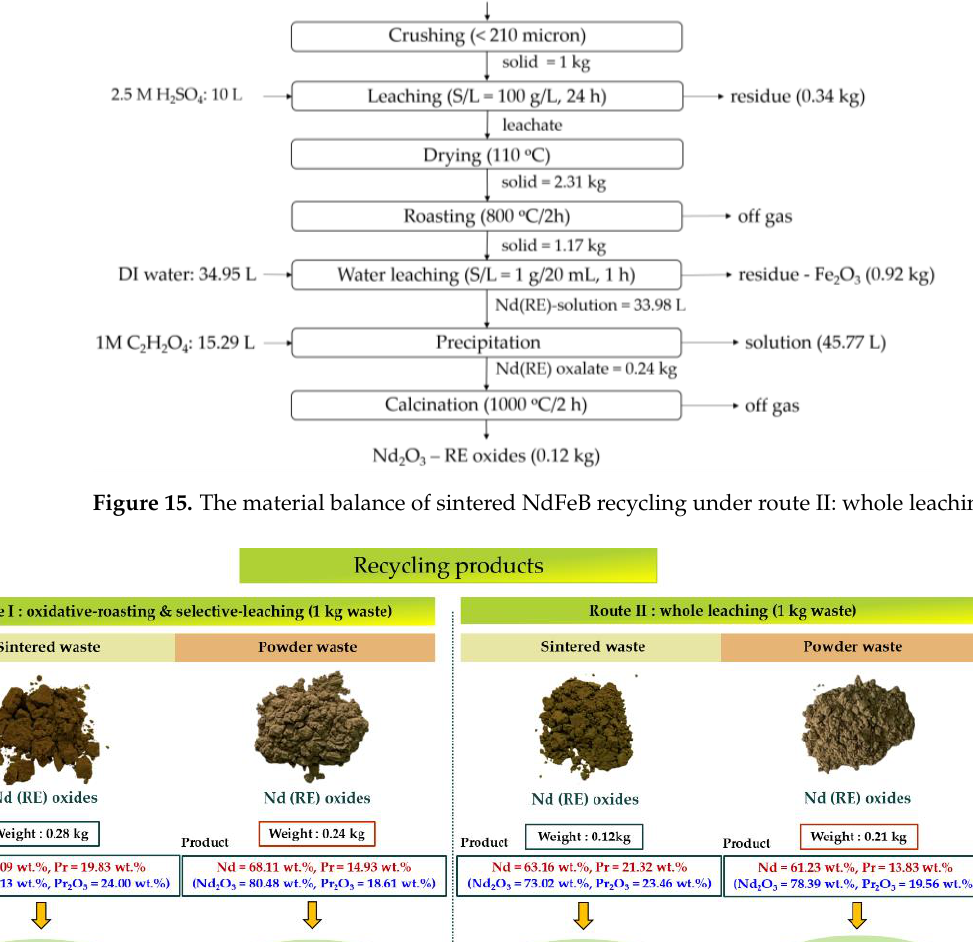
Figure 14. The material balance of sintered NdFeB recycling under route I: oxidative roasting and selective leaching.